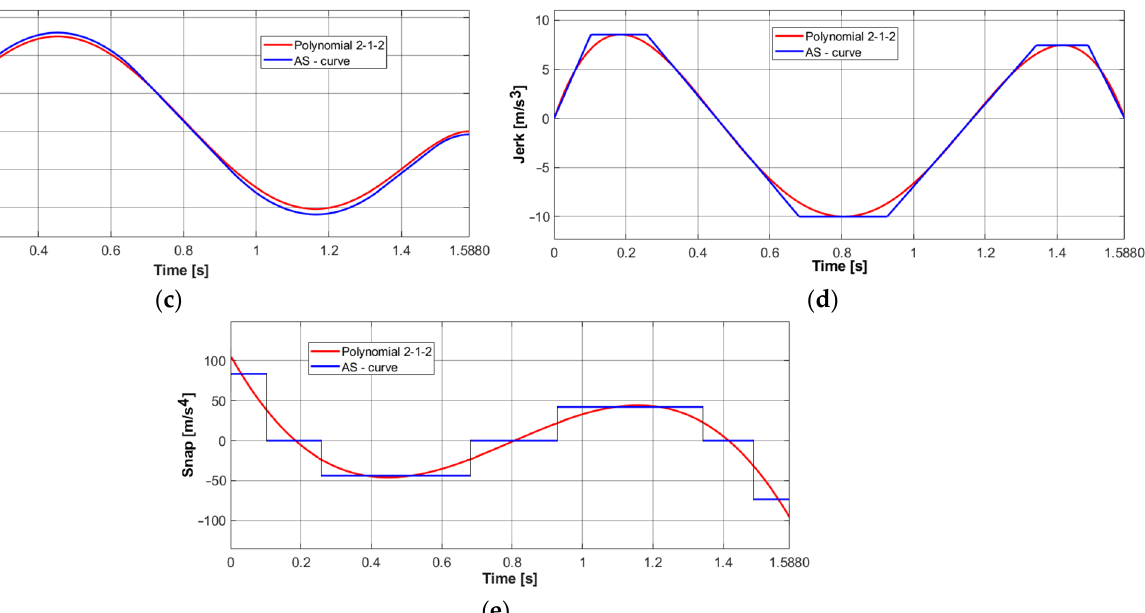
Figure 7. Profiles of kinematic quantities for the polynomial 2-1-2 and AS-curve: ( a ) displacement, ( b ) velocity, ( c ) acceleration, ( d ) jerk, ( e ) snap.